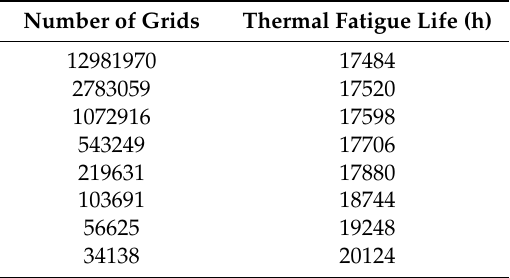
Table 2. Computational grid data of the flip chip component